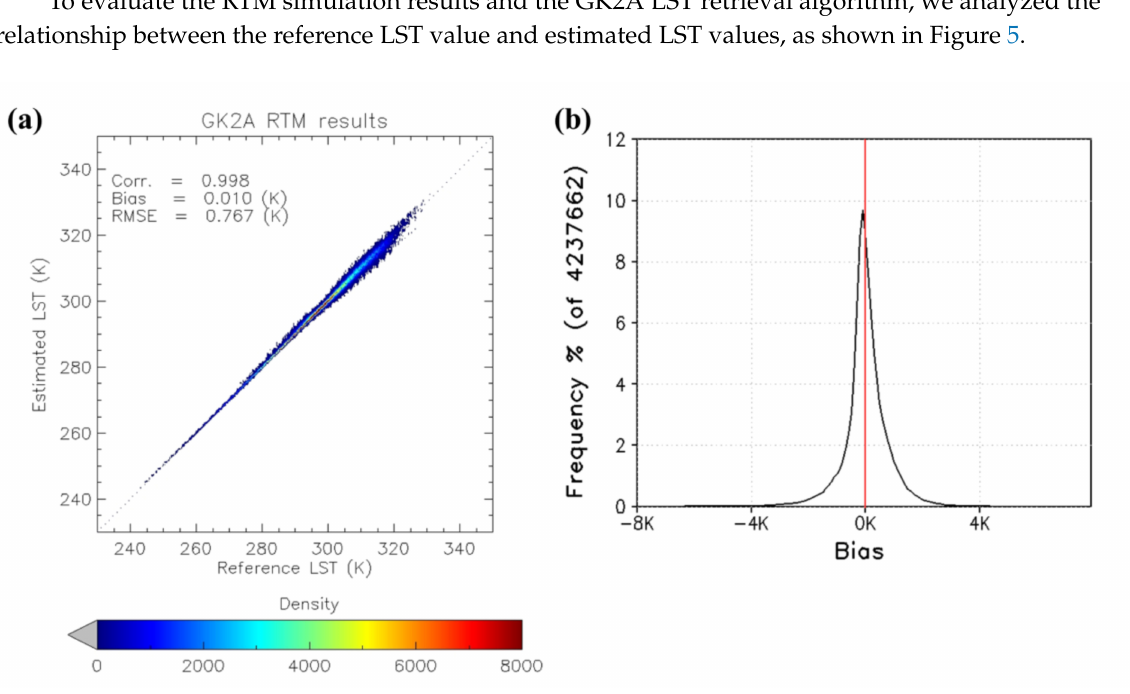
Figure 5. ( a ) Scatter plot (left) and ( b ) bias distribution (right) between the reference LST and estimated LST values using the GK2A / AMI LST retrieval algorithm (gray dotted line in ( a ) represents the 1:1